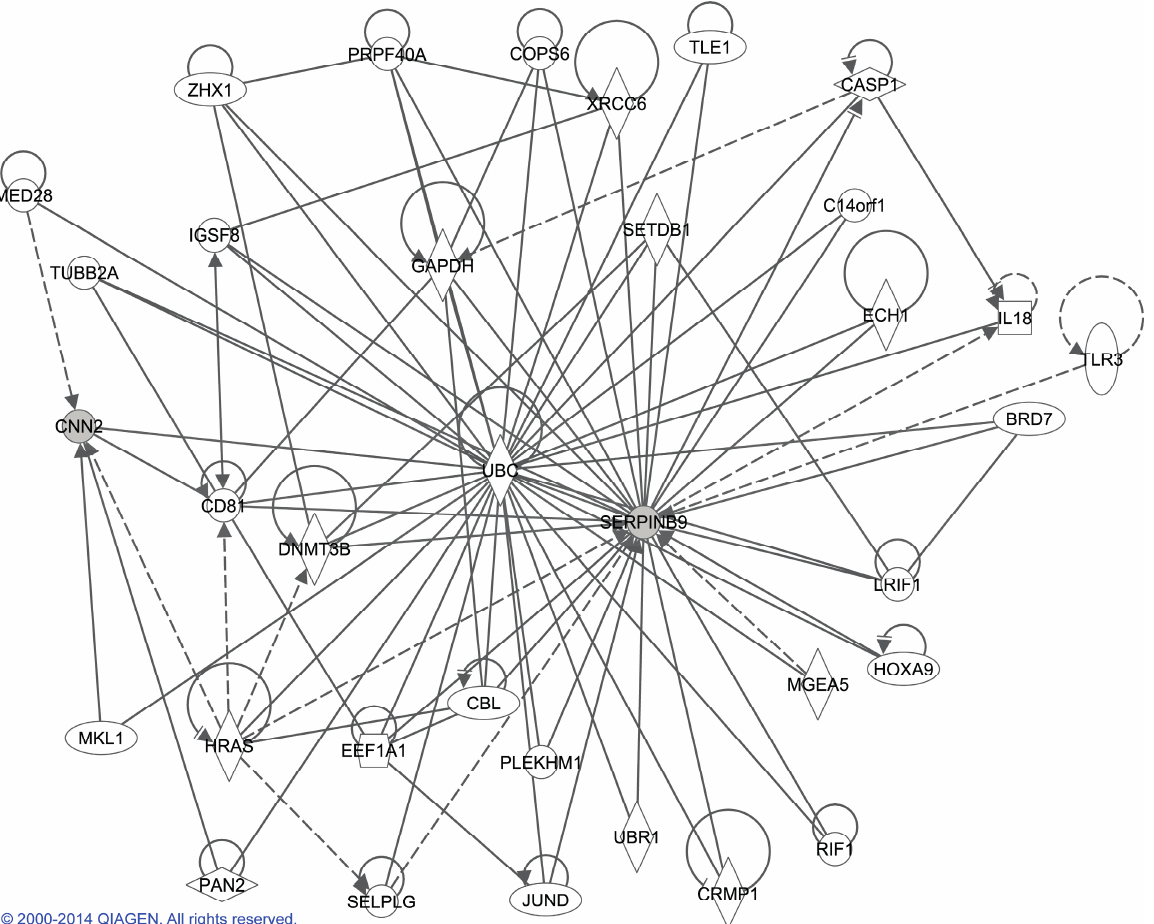
Figure 4. Network of interactions between CNN2 and SERPINB9 . Ingenuity Pathway Analysis ® (Qiagen’s Ingenuity Systems, Redwood City, CA, USA) tool was used for the analysis. Molecules are represented as nodes, and the biological relationship between two nodes is represented as a line. Solid lines represent direct interactions and dashed lines indirect interactions. All lines are supported by at least one literature citation or from canonical information stored in the Ingenuity Pathways Knowledge Base (Qiagen’s Ingenuity Systems). Nodes are displayed using various shapes that represent the functional class of the gene